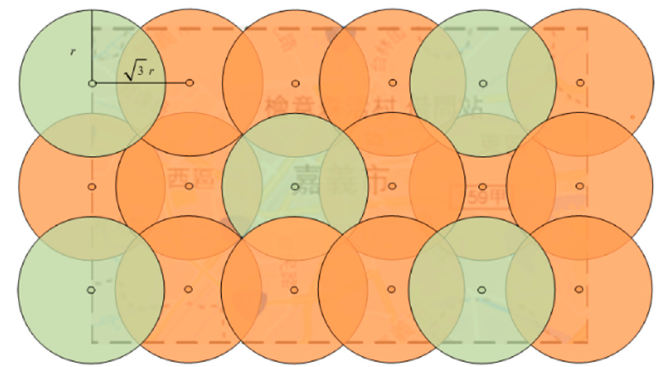
Figure 5. The unit disk covers the target region.